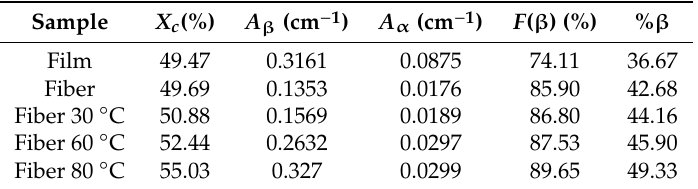
Figure 4. X-ray di ff ractograms for P(VDF-HFP) film, fiber, and fiber mats compressed at 30 ◦ , 60 ◦ , Figure 4. X-ray diffractograms for P(VDF-HFP) film, fiber, and fiber mats compressed at 30°, 60°, and and 80 ◦ C. 80 °C . Table 1. Analysis of the β -phase fraction in the crystalline region of the Table 1. Analysis of the β -phase fraction in the crystalline region of the samples .